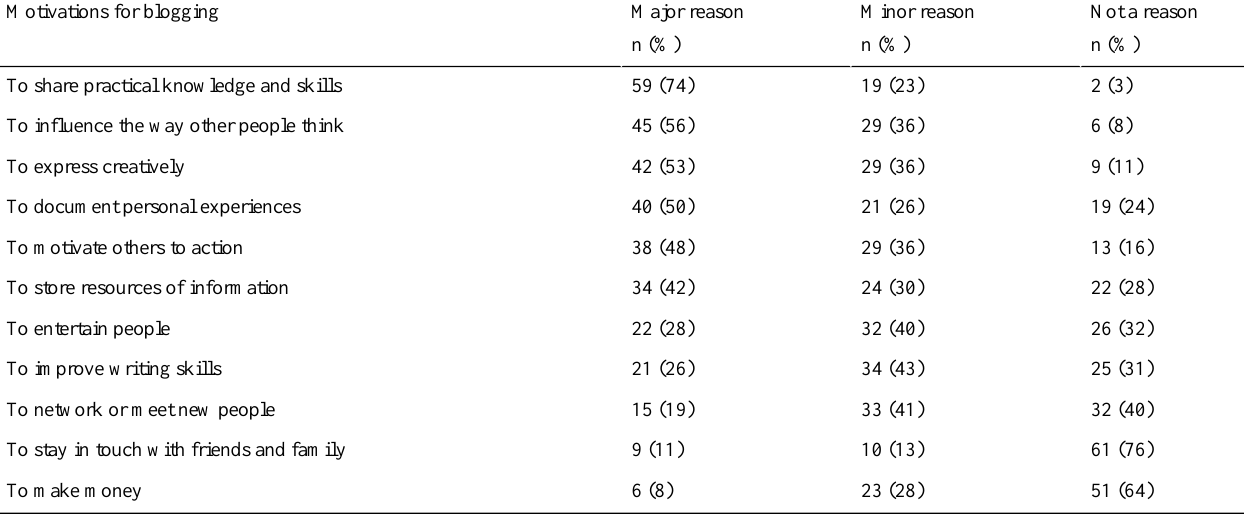
Table 5. Motivations for blogging of the responding medical bloggers